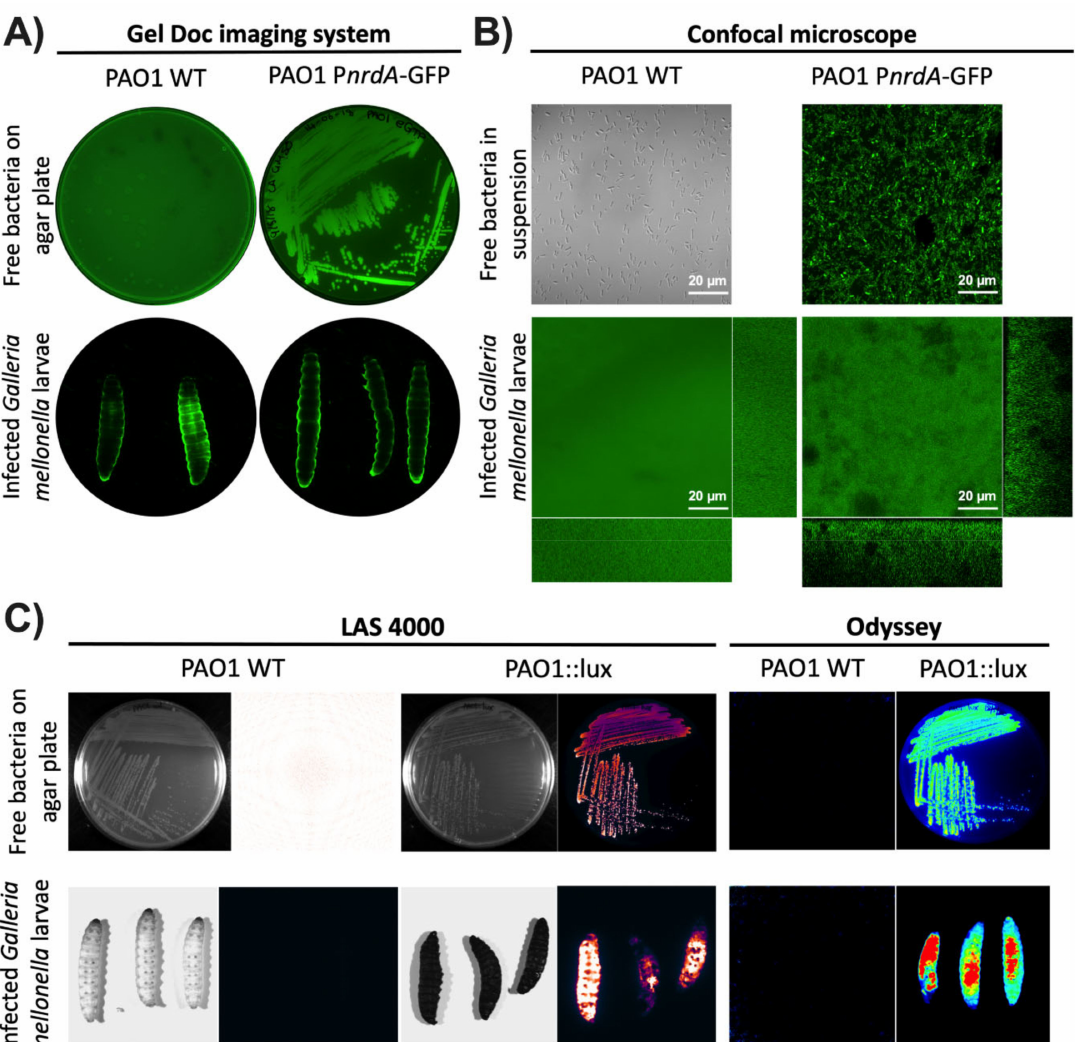
Figure 1. Visualization of G. mellonella larvae using di ff erent imaging methodologies. P. aeruginosa PAO1 wild-type (WT) and PAO1::eGFP strains were imaged using ( A ) the Gel Doc ™ imaging system G. mellonella larvae. ( C ) P. aeruginosa PAO1 wild-type (WT) and PAO1::lux were imaged as free